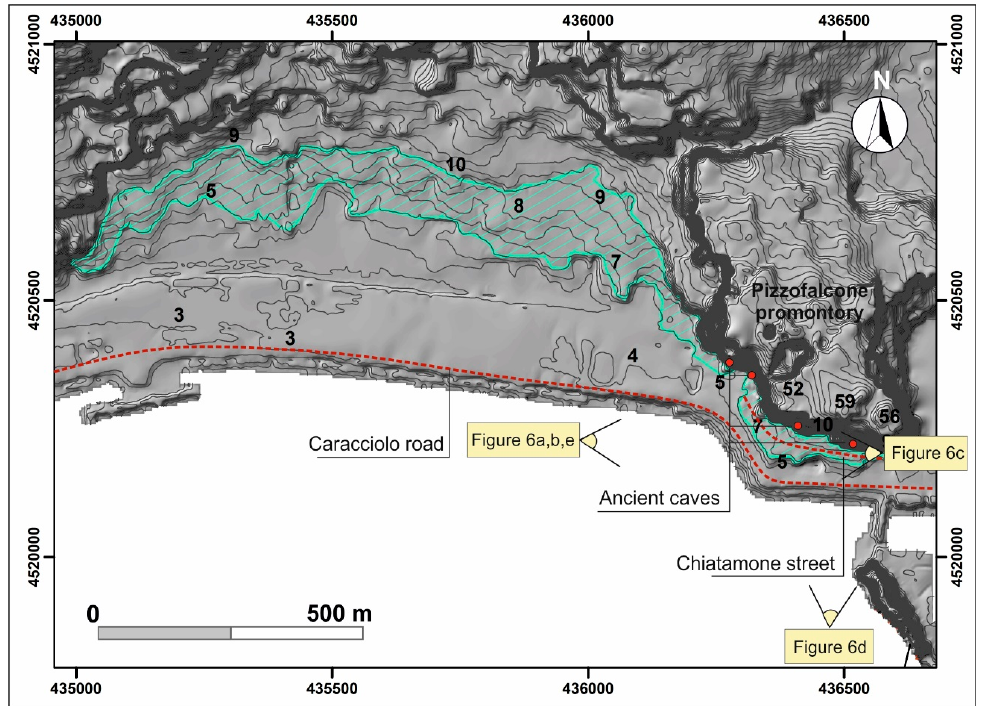
Figure 5. High-resolution DTM of the study area (1 × 1 m) with the first order paleo-shore platform highlighted with inclined green lines, contour lines in grey, elevation spots in black, and the roads described in the main text in dashed red.